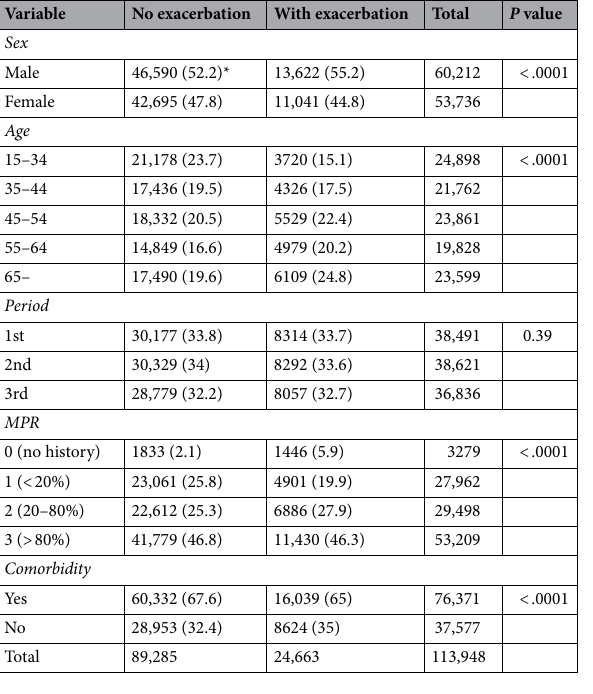
Table 1. Baseline characteristics of the study population: frequency, proportion, and P value from chi-square test for explanatory variables and exacerbation. *Percentage of patients by explanatory variables